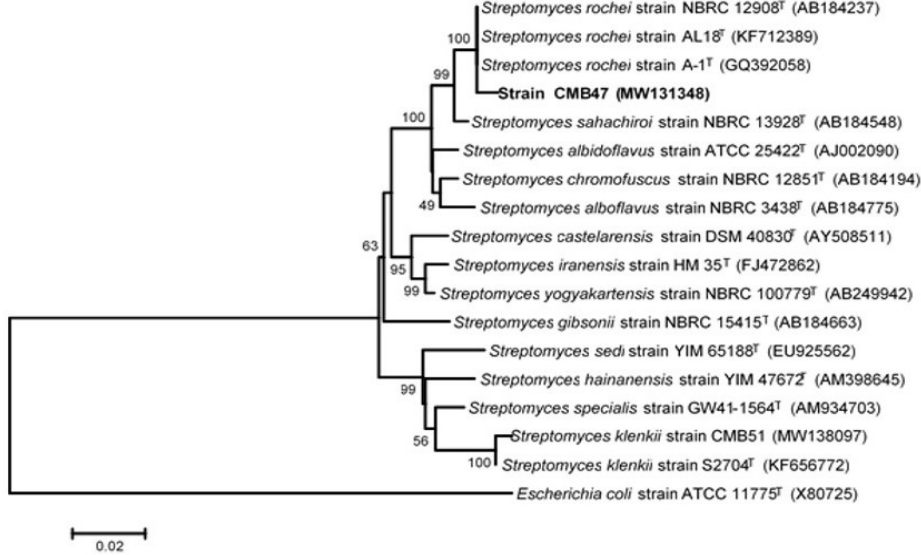
Figure 2. Phylogenetic tree based on 16S rRNA gene sequences, showing the position of strain CMB47 (GenBank accession no. MW131348) within the radiation of the genus Streptomyces . The sequence of E. coli strain ATCC 11775 T (accession no. X80725) was chosen as an outgroup. Numbers at the nodes indicate the level of bootstrap support (%); only values > 50% are shown. GenBank accession numbers are given in parentheses. Bar, 0.02 nt substitutions per base.